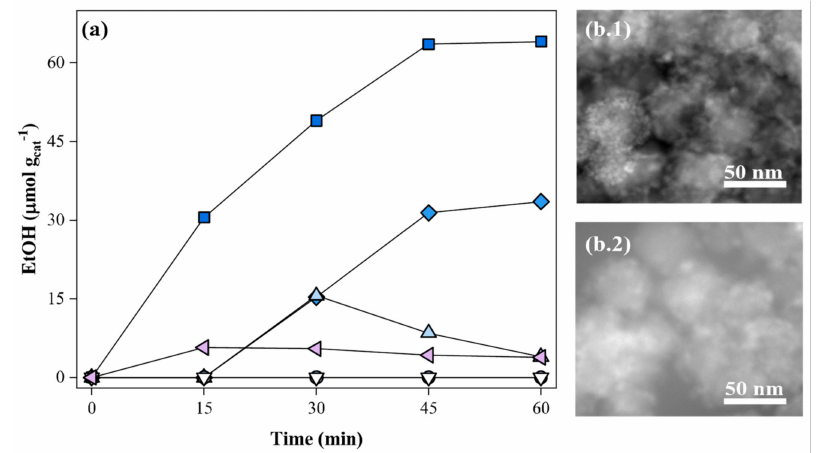
Figure 9. ( a ) Evolution of the ethanol production from CO 2 and C 2 H 6 as a function of photoreaction time, after (i) 1 cycle ( ), 2 cycles ( ), 3 cycles ( ) and 4 cycles ( ) of the photocatalyst use, and (ii) reactivation of the photocatalyst, resulting from the 4th cycle, with H 2 flow ( , at 200 ◦ C for 2 h) or air-driven calcination ( , at 350 ◦ C for 2 h). Experimental conditions: 20 mg of SrTiO 3 :RuO 2 :NiO; [Ru]:[Ni] = 1:1 (molar); Ru = 0.8 wt. %; P C = 1.01 bar; P CO = 0.35 bar; T = 200 ◦ C and I = 1000 W 2 H 6 2 m − 2 . ( b ) TEM images of the ( .1 ) fresh and ( .2 ) inactivated photocatalyst (after the 4th use).